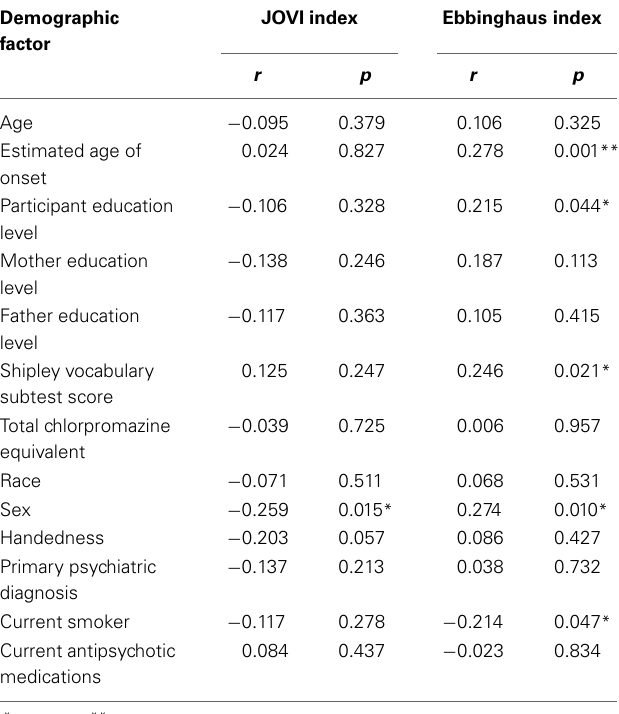
Table 2 | Spearman correlations of demographic factors and perceptual task indices.